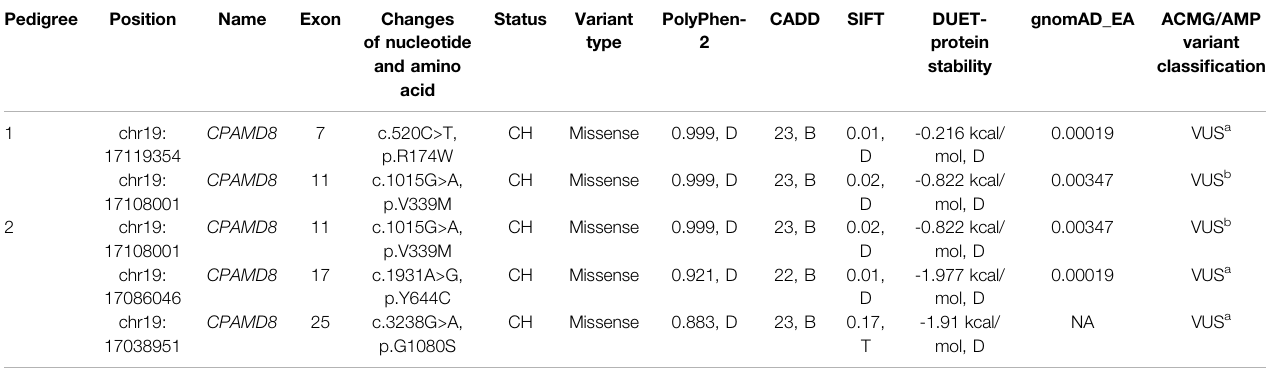
TABLE 3 | Summary of PG pedigrees with CPAMD8 Variants.